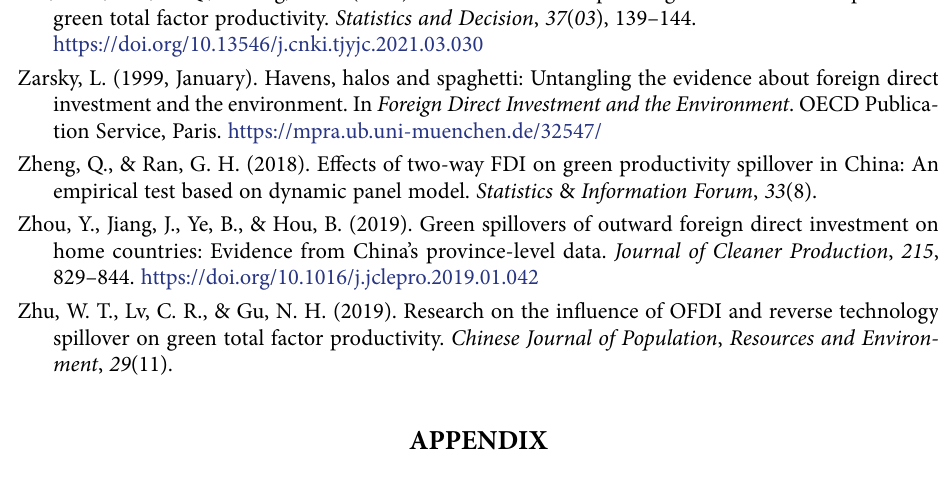
Table A.1. The result of the bootstrap